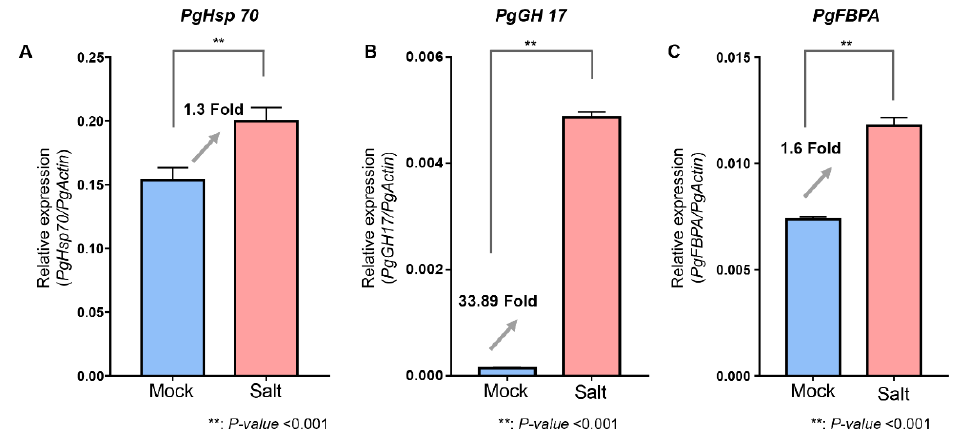
Figure 6. Bar charts showing the expression level of three genes, including Hsp70 ( A ), GH 17 ( B ), and FBPA ( C ), in ginseng roots after salt treatment at 48 h by qRT-PCR analysis. Asterisk mark (**) indicated statistically significant differences in each sample ( p -value < 0.001).